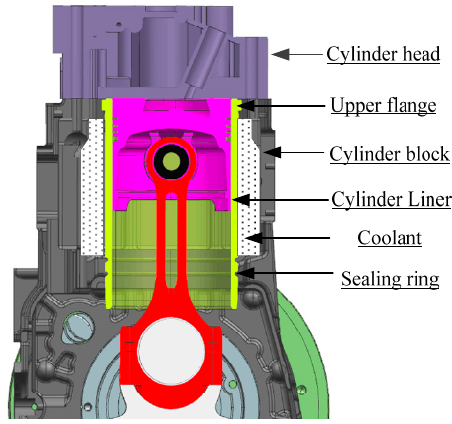
Figure 1. Construction of wet cylinder liner.